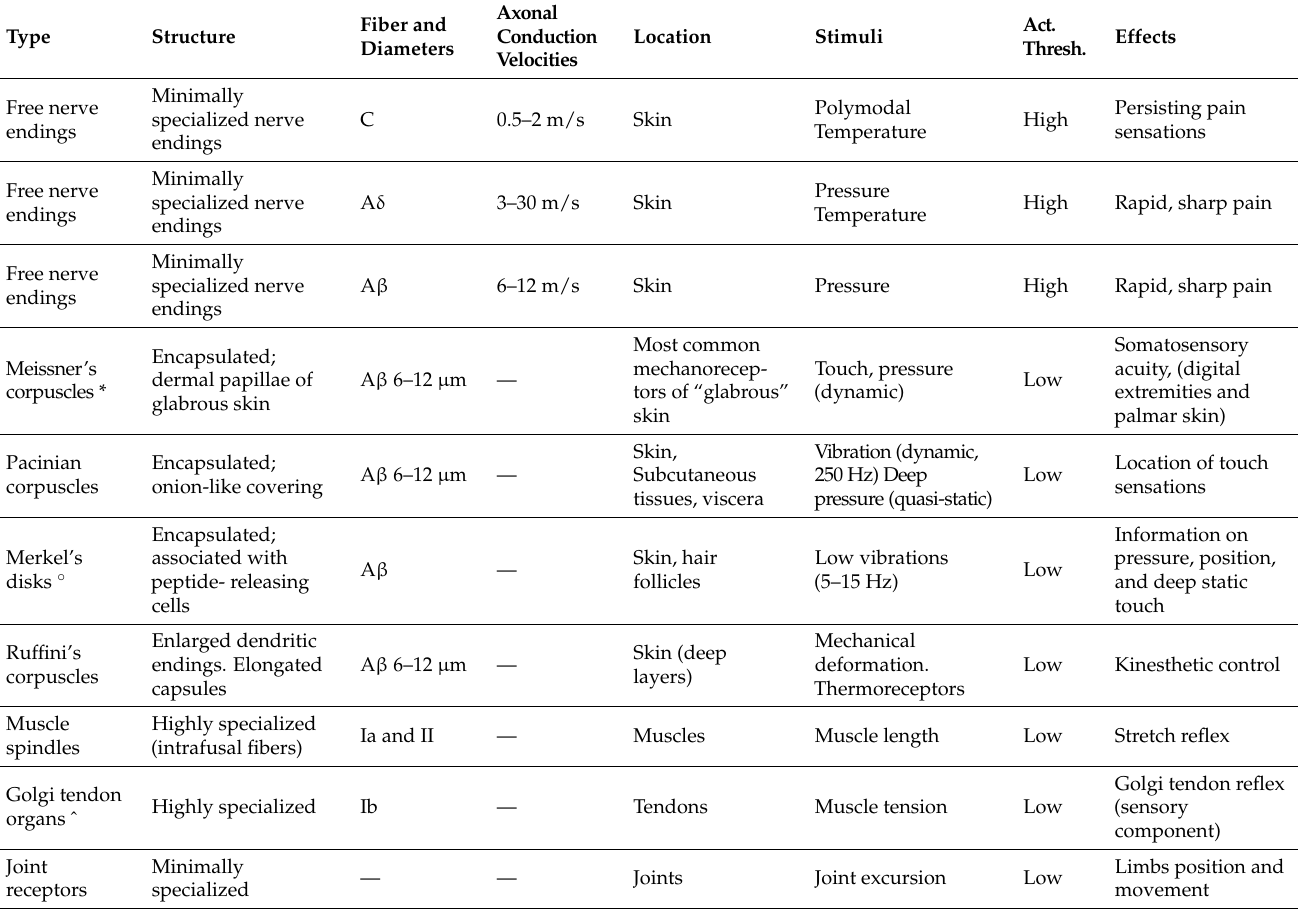
Table 1. Main properties of sensory receptors (free nerve endings and organs)